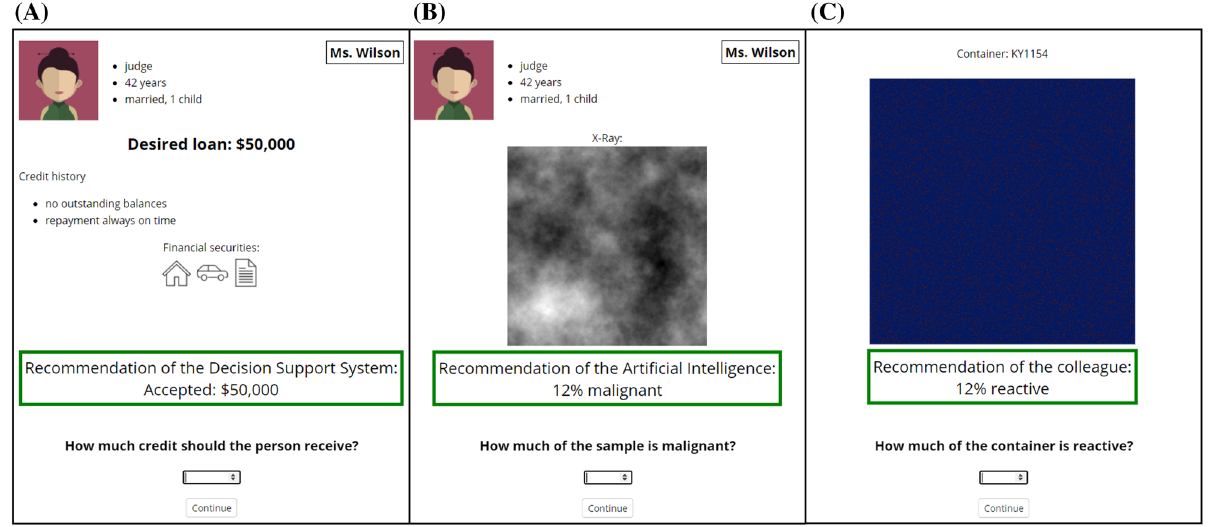
Figure 2. Depiction of the second trial in the decision support system condition in the context loan assignment of Experiment 1 ( A ), the artificial intelligence condition in the context radiology of Experiment 2 ( B ), and the human condition in the chemical plant task context of Experiment 3 ( C